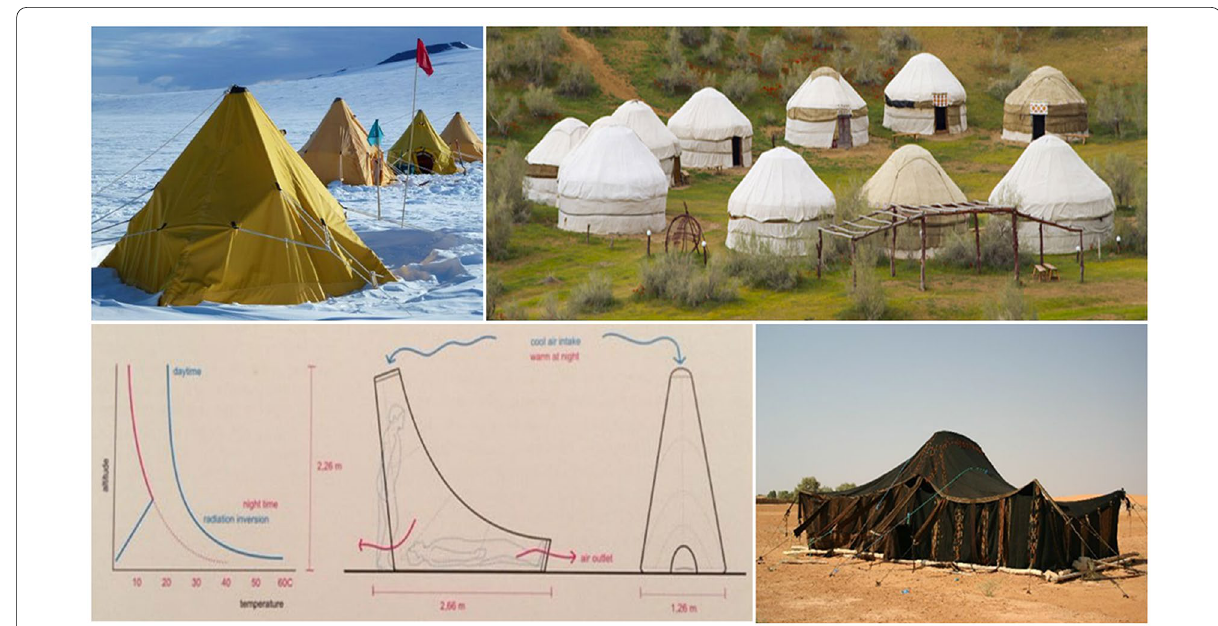
Fig. 3 Examples of traditional refugee tents on top and bottom left, the DesertSeal by ESA and bottom right the Tuareg tent by